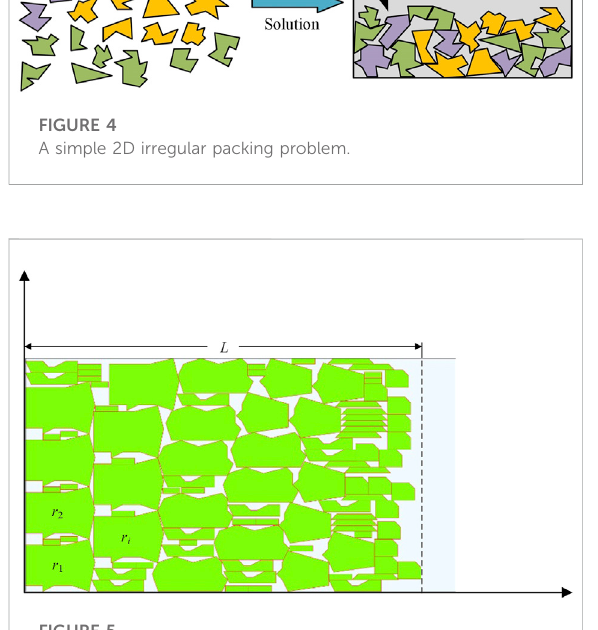
FIGURE 5 Mathematical model of 2D irregular packing problem.